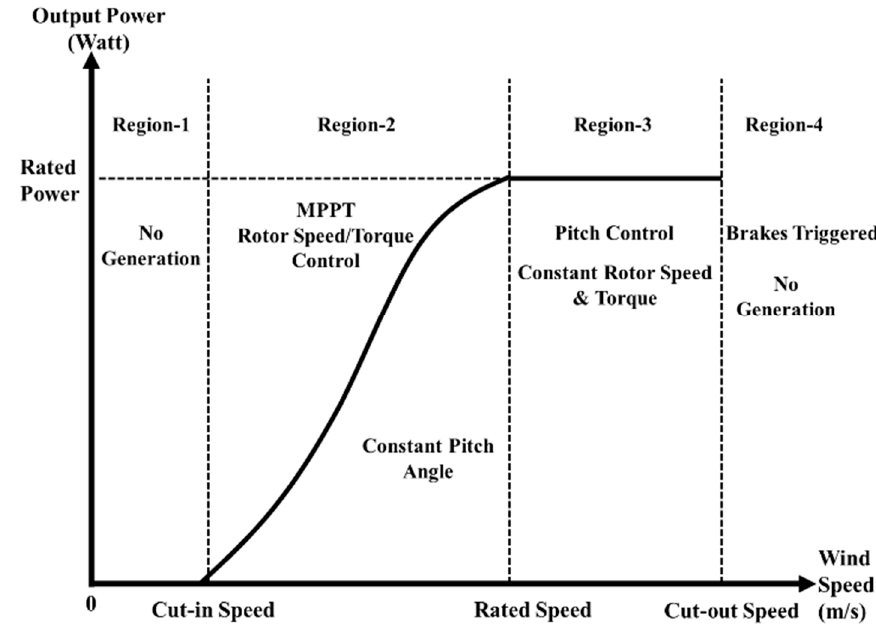
Figure 1. The characteristic curve of wind turbine operation.